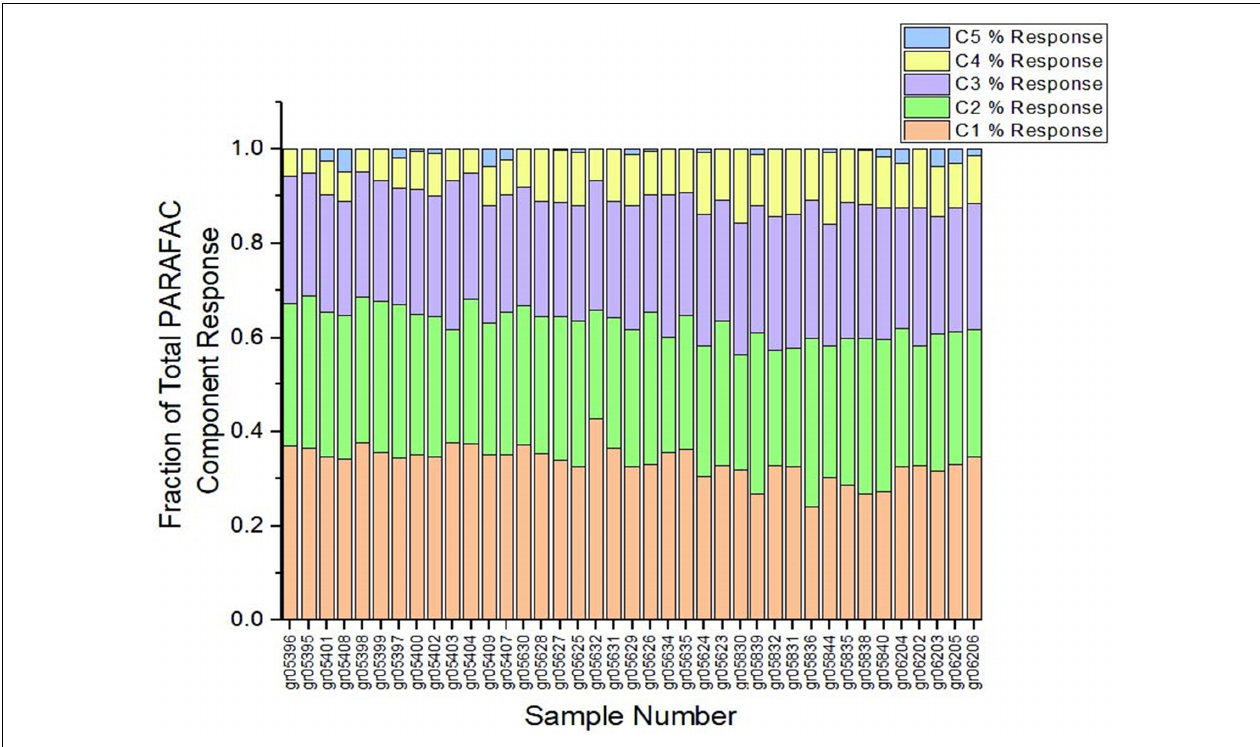
FIGURE 2 | Percent of total response by PARAFAC component. As shown, samples maintained a similar proportion of each of the five PARAFAC components, suggesting that presence of disruptive fluorophores—that is, fluorophores that could disproportionately affect total EEMs response—is unlikely.